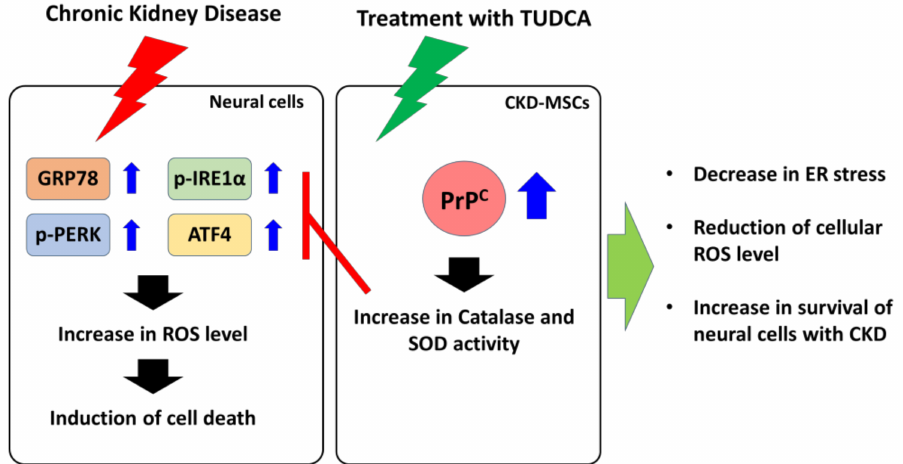
Figure 5. Schematic representation of the proposed mechanisms by which TUDCA-treated CKD-MSCs protect against neural cell apoptosis induced by CKD-mediated ER stress. TUDCA-treated CKD-MSCs induce the expression and secretion of PrP C , leading to increased levels of PrP C in neural cells. Under the presence of uremic toxin, the upregulation of PrP C inhibits CKD-mediated ER stress in neural cells through the induction of catalase and SOD activities, resulting in increased survival of neural cells in subjects with CKD. Blue array means that increase expression or activation of protein. Red “T” arrow means that block expression or activation of protein. Black array means cell signal pathway. Green arrow means TUDCA-treated CKD-MSCs finally protection